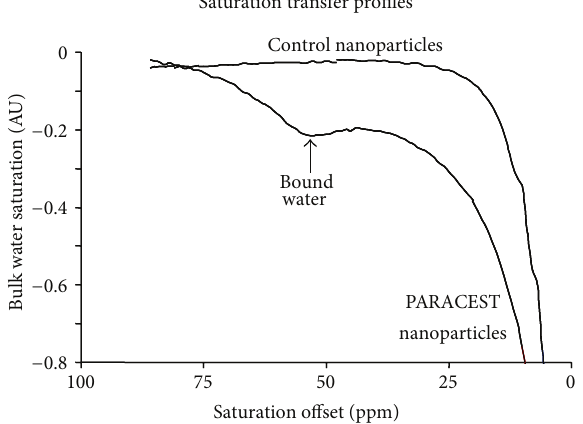
Figure 2: PARACEST nanoparticles display a very obvious satu- ration transfer effect at 52 ppm (arrow), resulting from saturation of the bound water peak which is effectively transferred into the bulk water pool. Nanoparticles that do not contain the PARACEST chelate do not show any saturation transfer effects at this frequency offset. Reprinted with permission from